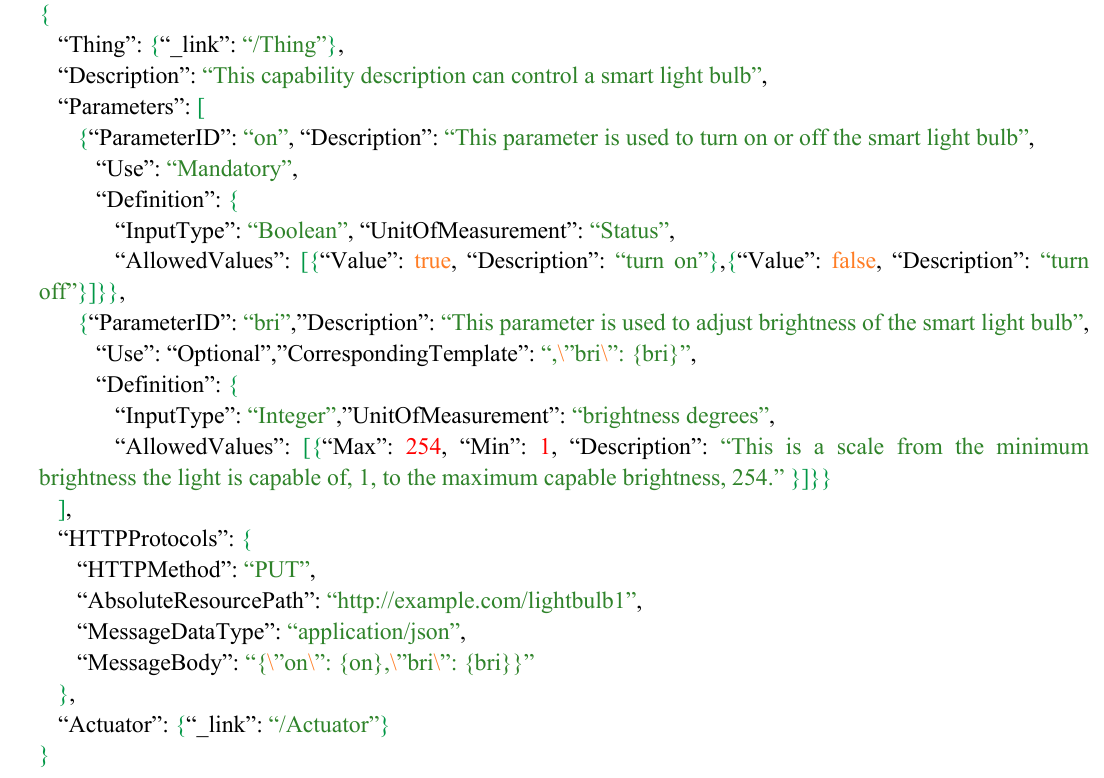
Figure 6. An example of a tasking capability description for a smart light bulb.